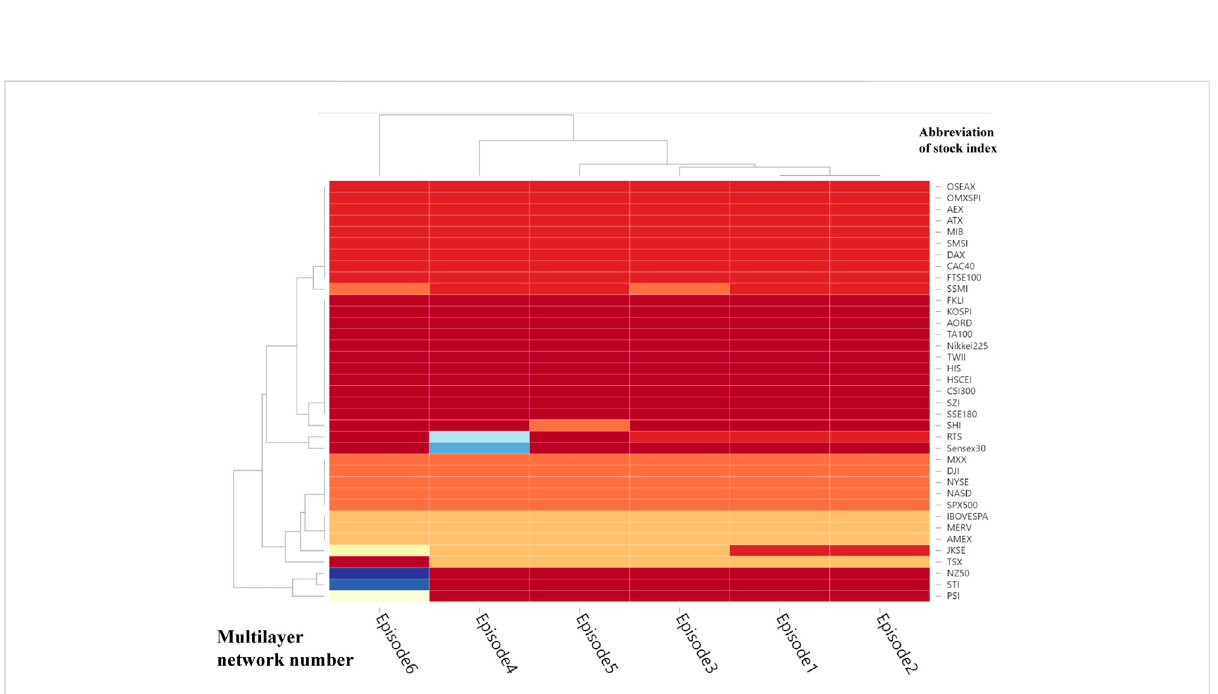
FIGURE 7 (Color online) Community division results of the multilayer network at the beginning of the fi nancial crisis, obtained via a Multi-infomap algorithm. The horizontal axis means the Layer ID, Episode1 to 6 correspond to Layer1 to 6 respectively. The vertical axis shows the abbreviations of all